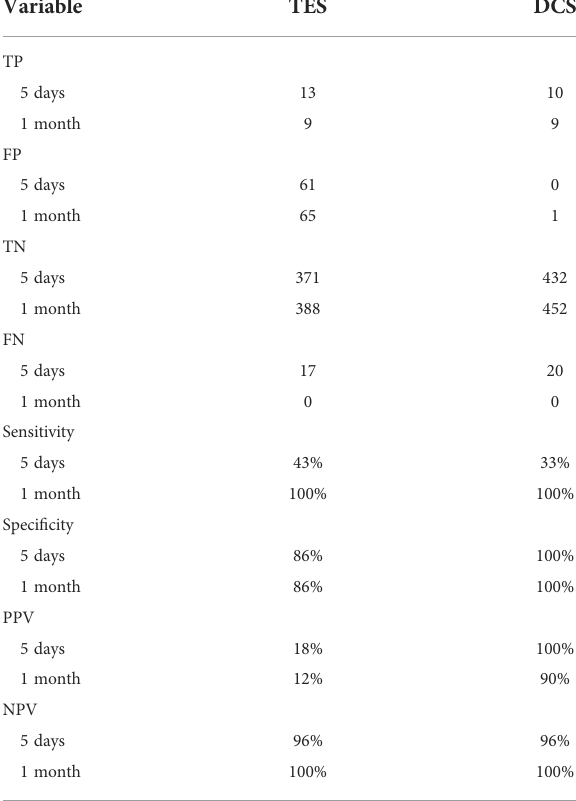
TABLE 3 TES and DCS